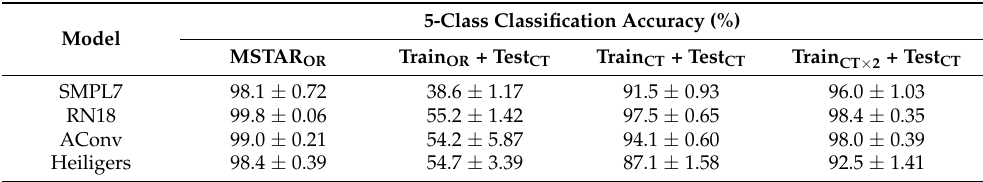
Table 4. Improved robustness against the background changes in test samples by introducing training samples with diverse clutter backgrounds.